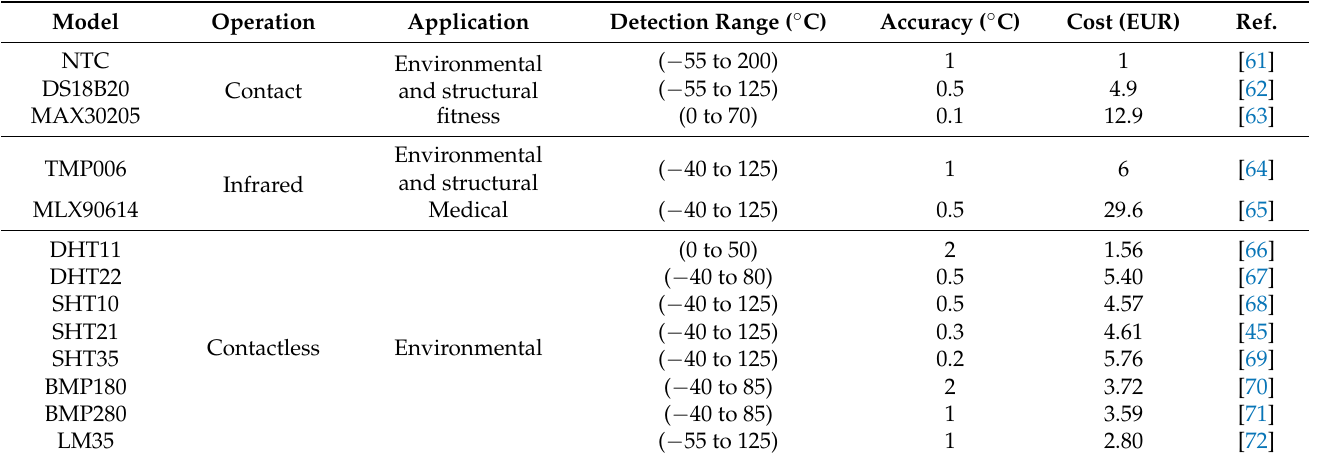
Table 2. List of the common contact, contactless, and infrared temperature low-cost sensors in the